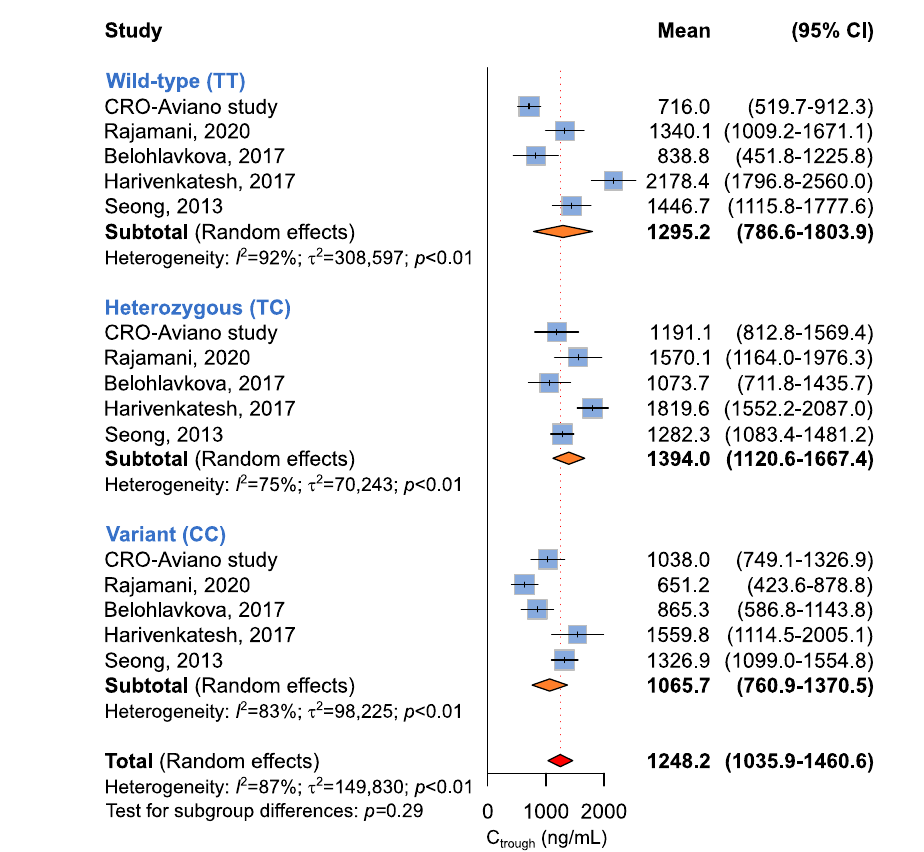
Figure 4. Forrest plots for the association between ABCB1 c.1236C>T and imatinib C trough levels for individual genotypes (allelic model) [14,16,18,19].